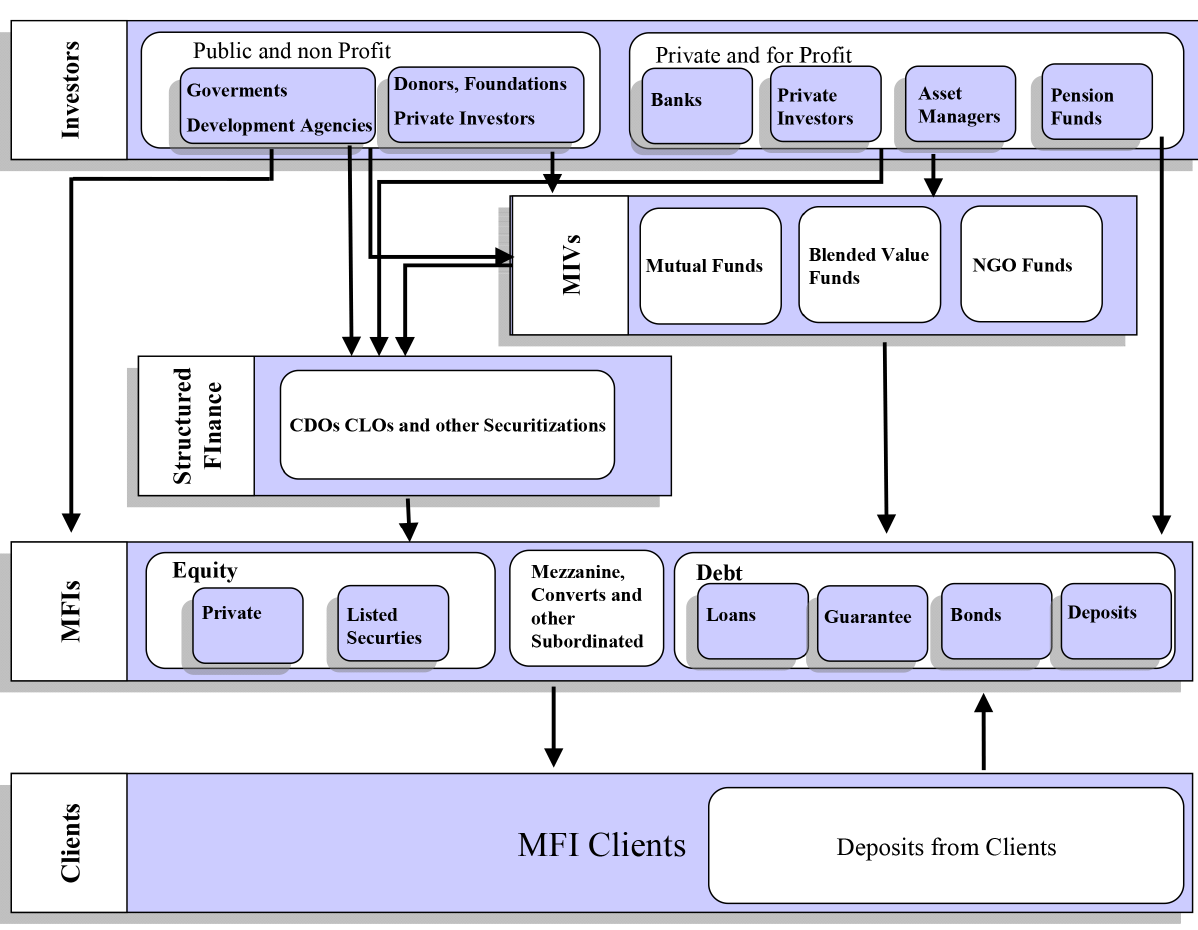
Figure 4. MFI Funding Market